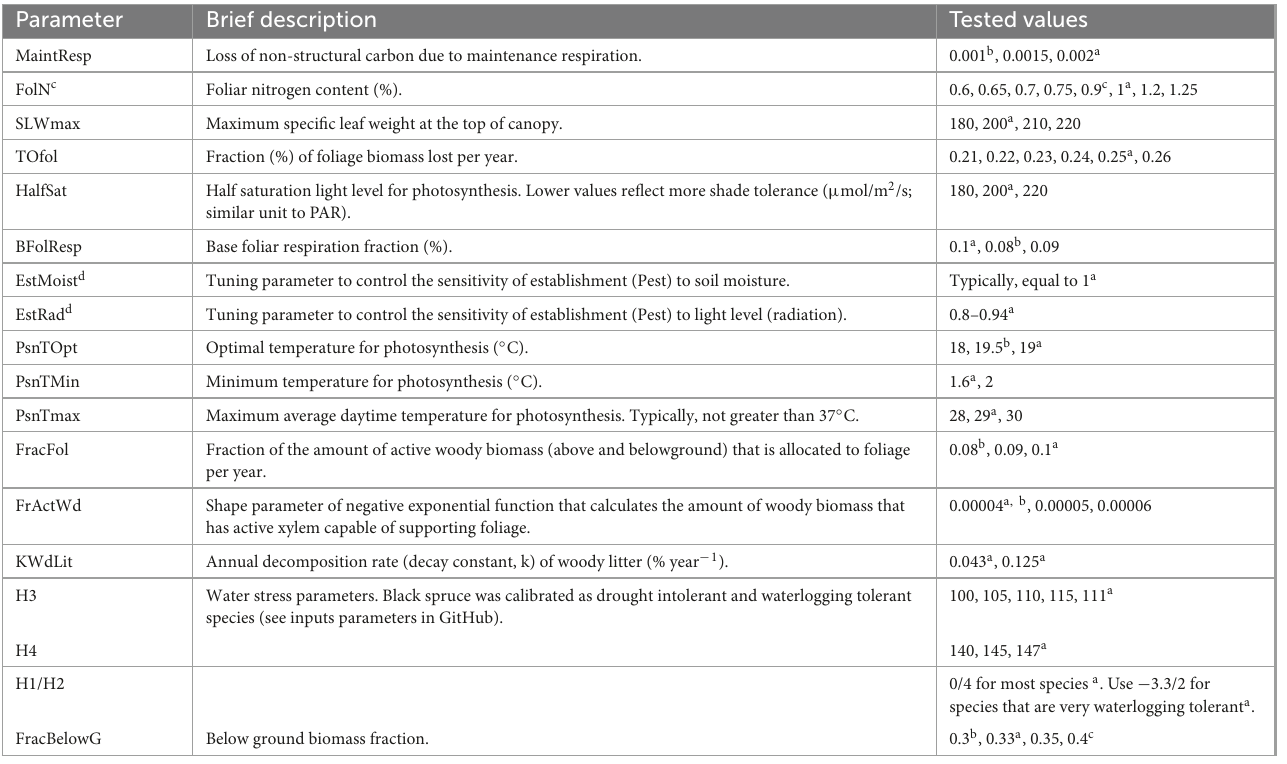
TABLE 3 An example of the tested values of 19 parameters for black spruce in MU1. Parameter Brief description Tested values MaintResp Loss of non-structural carbon due to maintenance respiration. FolN c Foliar nitrogen content (%). Maximum specific leaf weight at the top of canopy. Fraction (%) of foliage biomass lost per